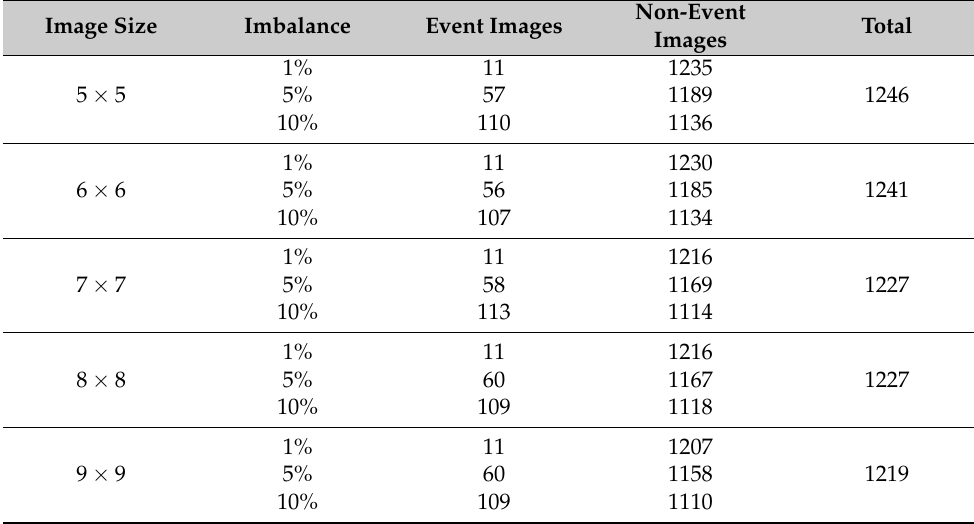
Table 2. Number of test images of each size across all class imbalance. Image